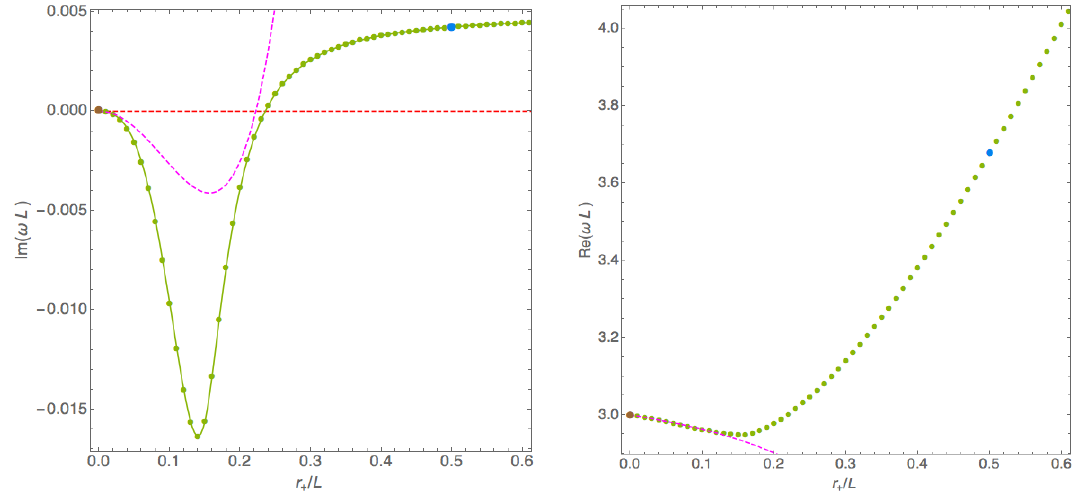
Figure 4 . Similar to (cid:12)gure 3 but this time for a scalar (cid:12)eld charge qL = 2 that is above the near-horizon bound (3.7) only for r + =L above a certain value as seen in the left plot of (cid:12)gure 1.